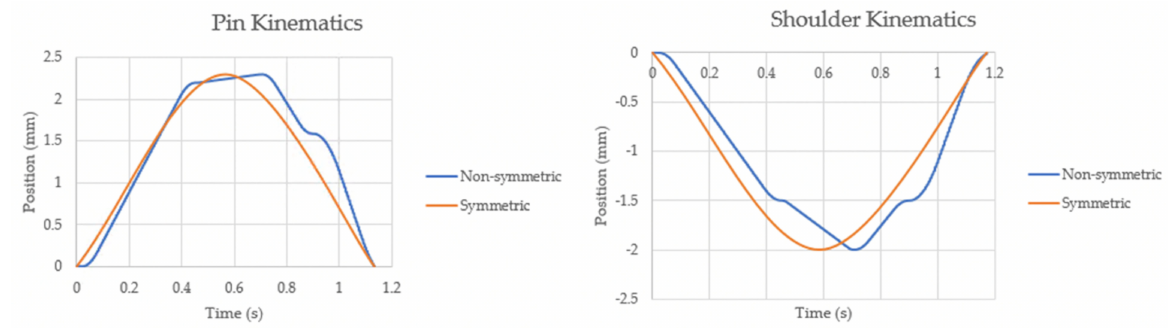
Figure 3. Bond Technologies RFSSW robotic end-effector.